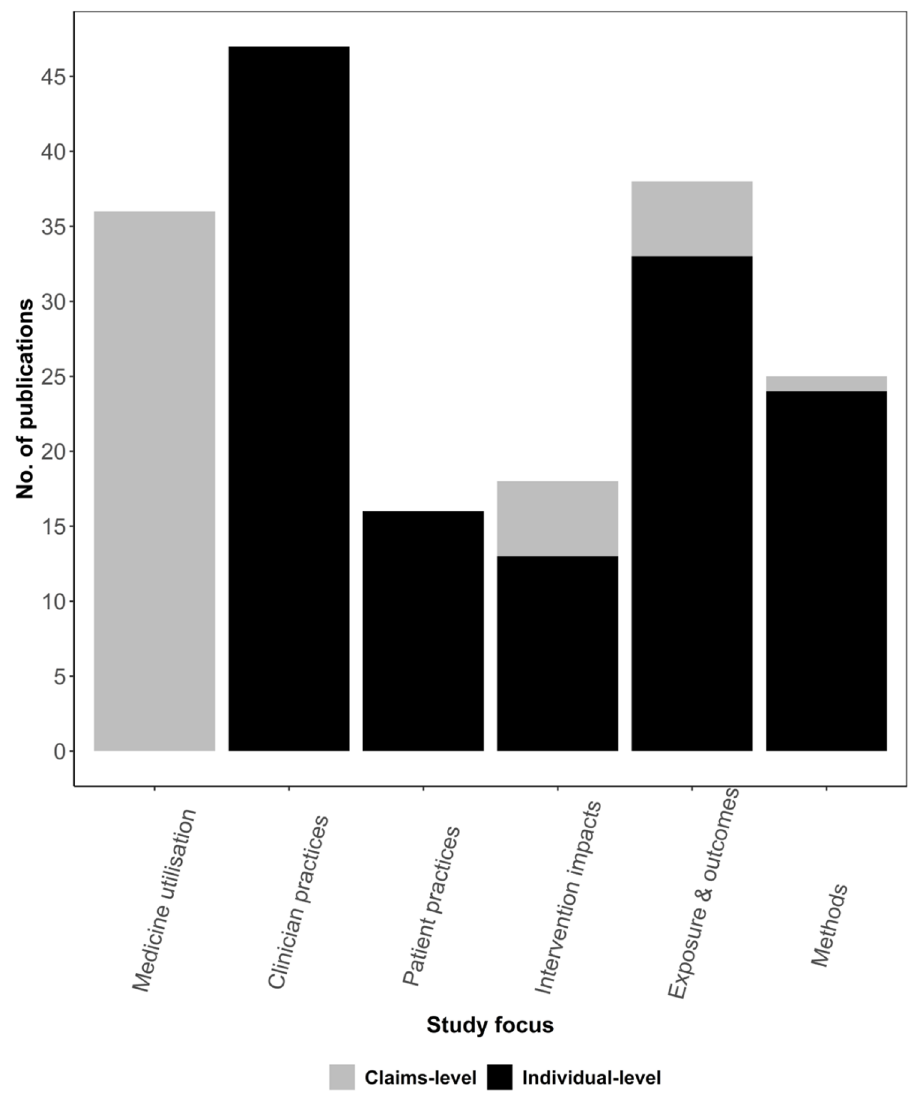
Figure 3: Number of studies according to study focus and analytical